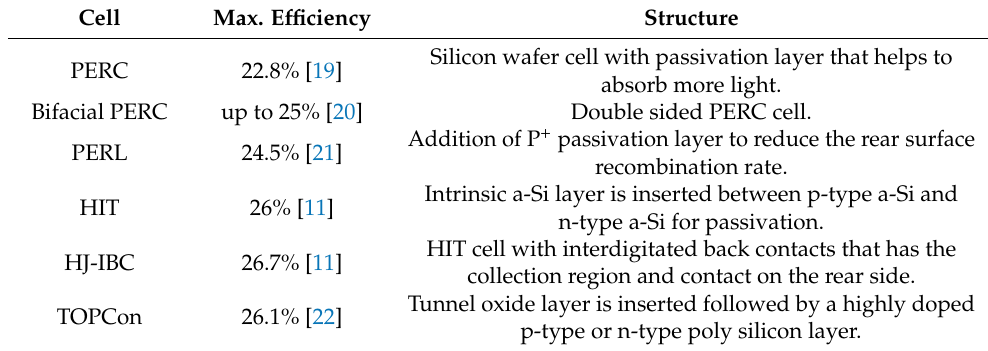
Table 1. Highly Efficient silicon based single-junction solar cells.